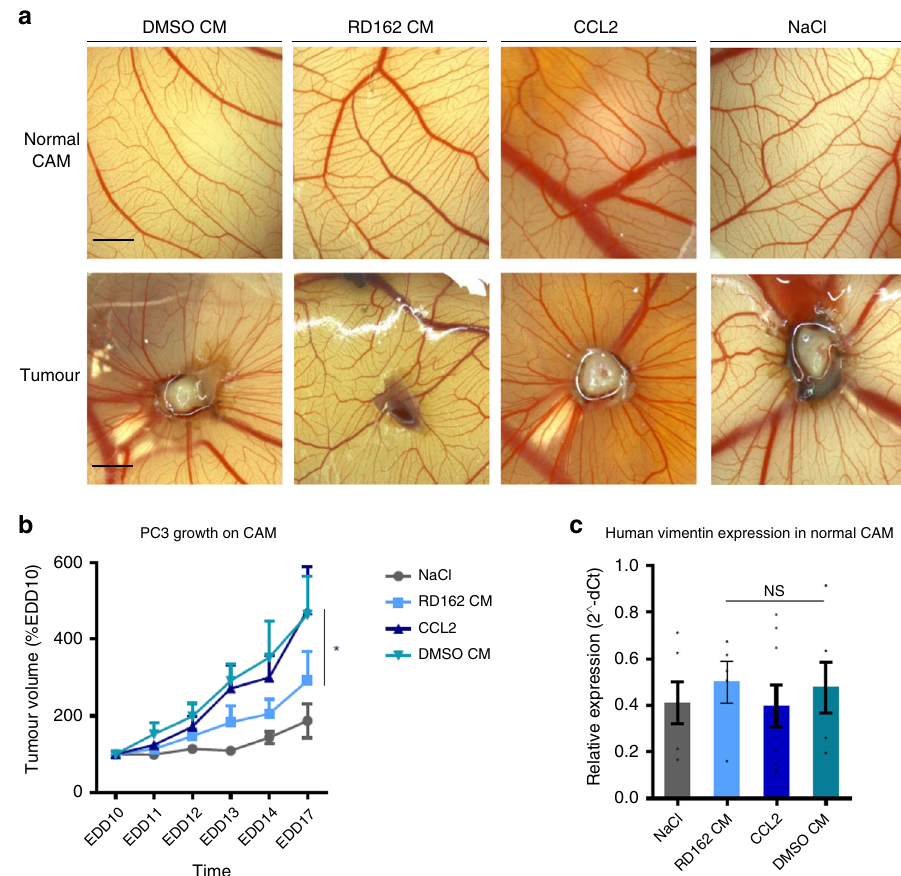
Fig. 4 AR signalling in THP-1 cells affects prostate tumour growth in vivo. a Representative images of both normal chick embryo chorioallantoic membrane (CAM) and PC3 PCa cells derived tumours growing on the CAMs replenished with CM of DMSO or RD162-treated THP-1 PMA;IFNG;LPS cells, CCL2 or NaCl,. The only tumour grown in NaCl-treated CAM conditions is shown. All other NaCl-treated CAMs showed no sign of tumour growth. Scale bar = 500 µ m. b Growth curves of PC3 tumours grafted into CAMs showing tumour volume over time in the different treatment conditions. Datapoints represent the average tumour volume as a percentage of the tumour volume at the start of treatment (EDD10). Error bars represent s.e.m. of 6 – 10 biological replicates per condition in one experiment with one batch of THP-1 PMA;IFNG;LPS cell CM (DMSO CM and RD162 CM). *: p = 0.02. p -value comparing DMSO CM versus RD162 CM was calculated using a Two-way Anova with a cutoff for signi fi cance of 0.05. Source data are provided as a source data fi le. c The expression of human vimentin in disseminated PC3 cells into CAM tissue distant from the primary tumour site (normal CAM) in the different treatment conditions and normalized to the reference gene human Cyclophylin A (2 − dCt ). Error bars represent the s.e.m. of 5 – 9 biological replicates per condition in one experiment with one batch of THP-1 PMA;IFNG;LPS cells CM (DMSO CM and RD162 CM). p = 1.0. p -value comparing DMSO CM versus RD162 CM was calculated using a One-way Anova test with a cutoff for signi fi cance of 0.05. NS: no signi fi cant difference. Source data are provided as a source data fi